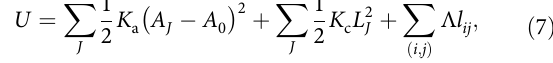
show that the PDFs of kinetic energy and enstrophy follow the